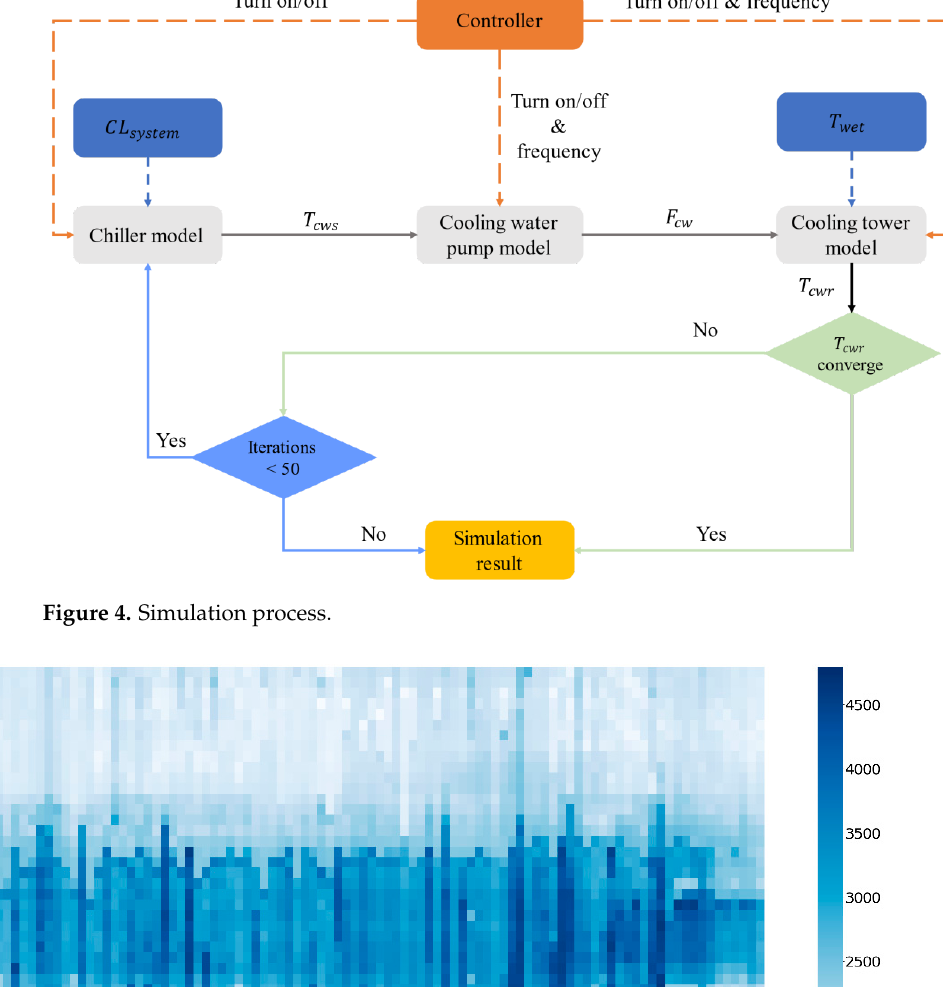
Figure 5. The temporal distribution of the cooling load. The deeper the color, the heavier the load.